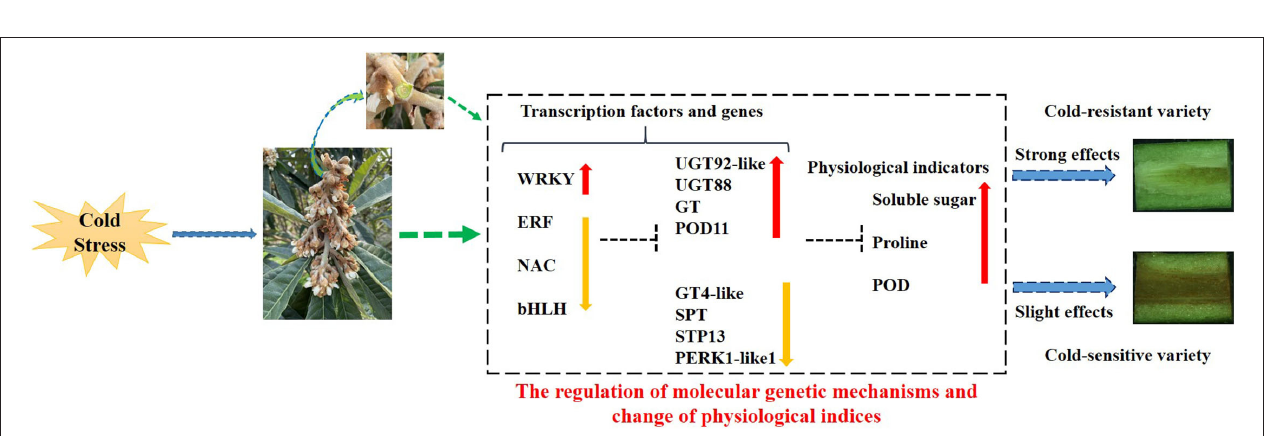
FIGURE 11 | Proposed model of molecular regulatory mechanism in response to cold stress of loquat. The red up-arrow indicates a significant increase; the yellow down-arrow represents a significant reduction; the dotted line “T” indicates a potential role of positive